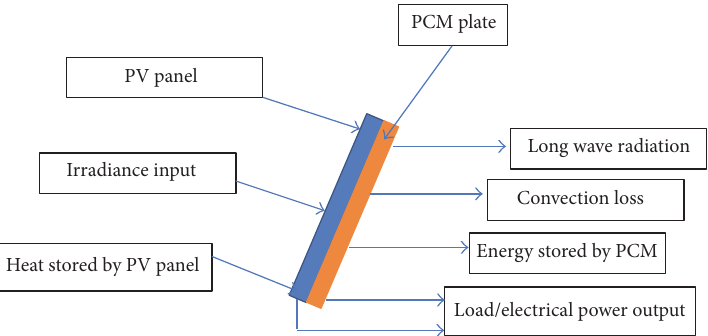
Figure 3: Thermodynamic reference model of PV-PCM